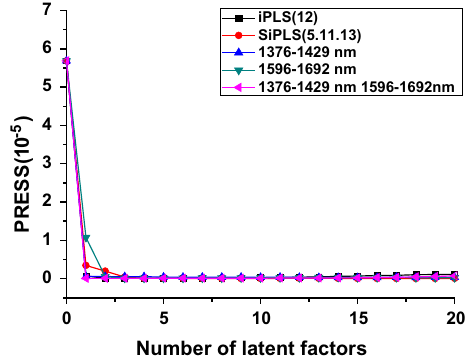
Fig. 6. The synchronous spectrum of deuterated chloroform (a) and raw spectra of Isopsoralen (b).